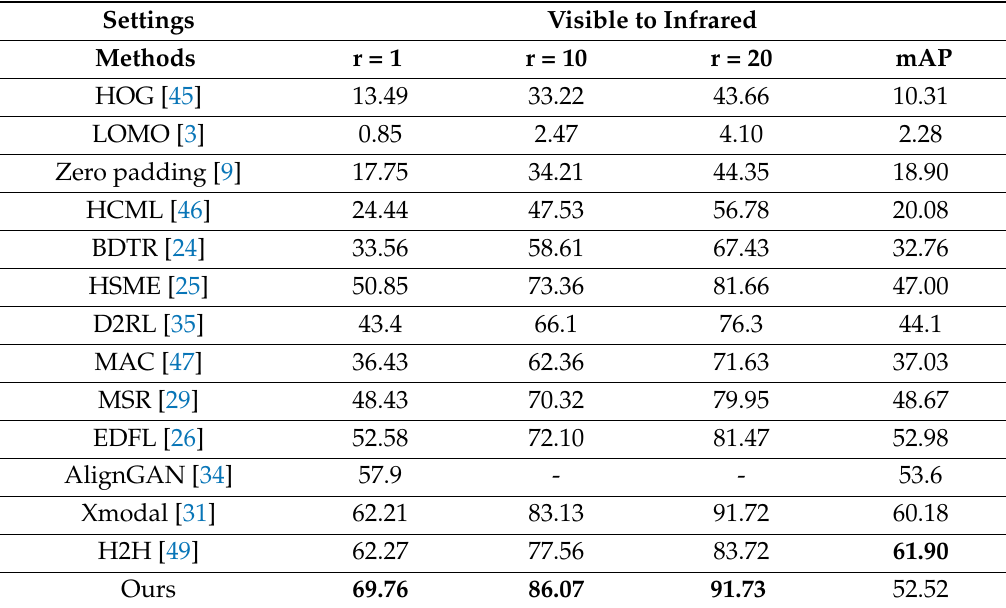
Table 2. Comparison of the results of the proposed method and other state-of-the-art methods based on the RegDB dataset. Bold numbers are the